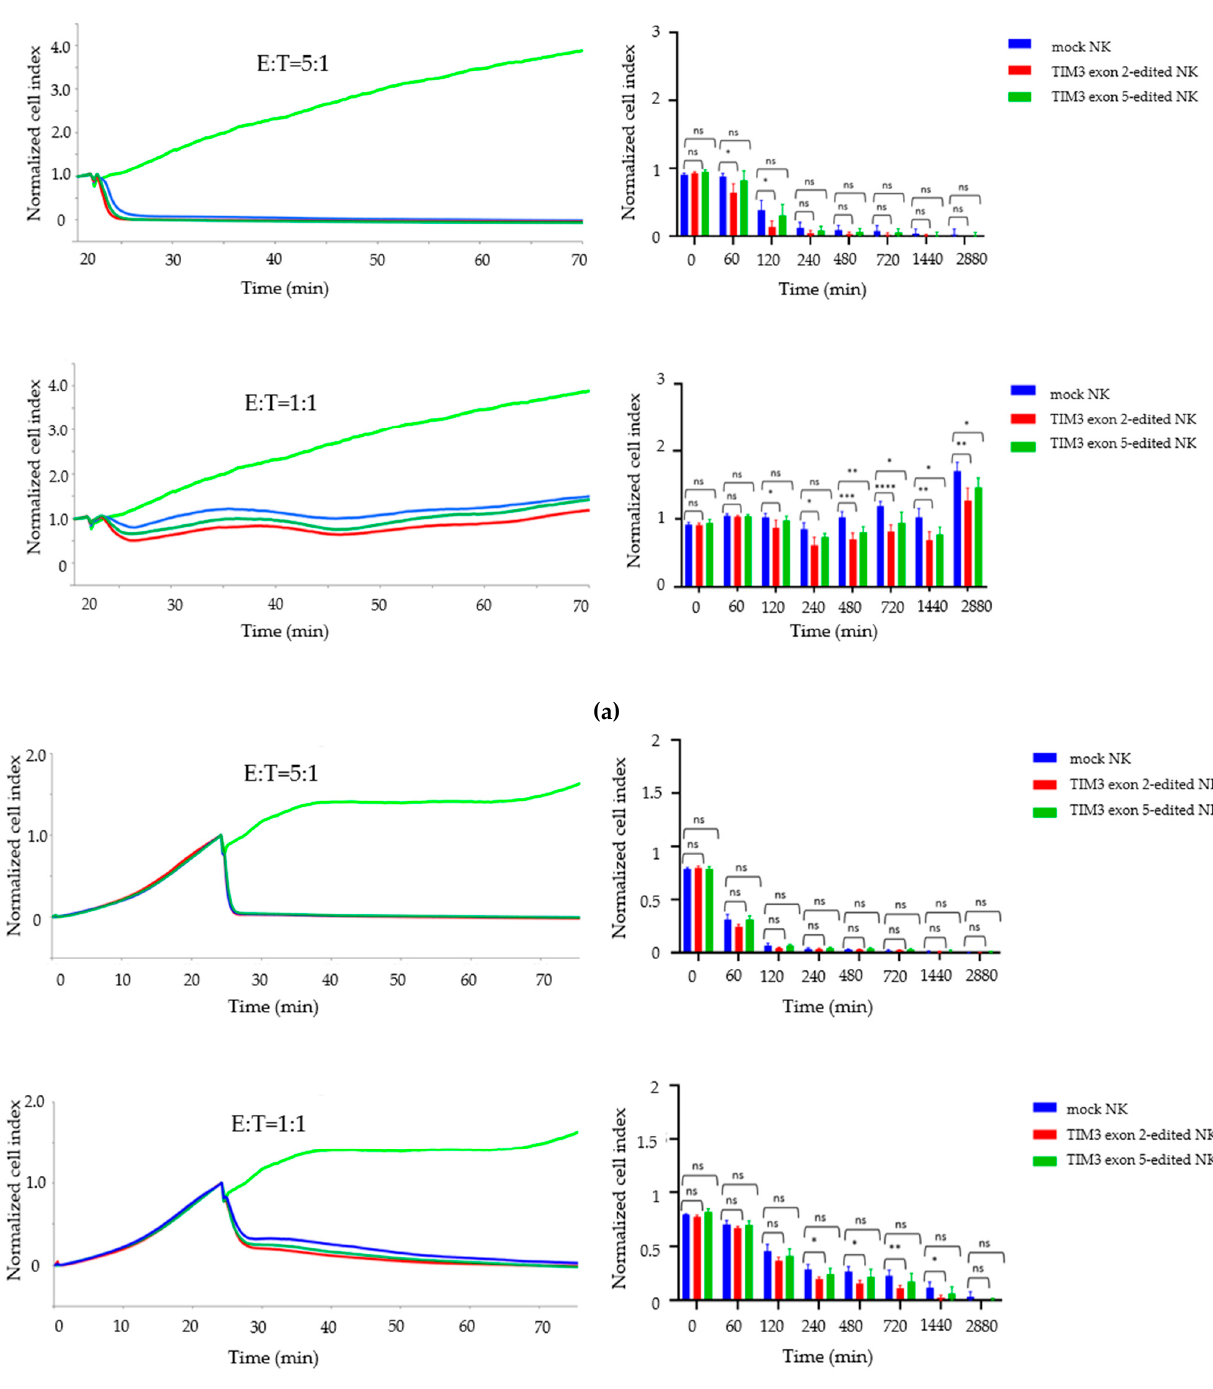
Figure 5. Enhanced growth inhibition of GBM cells by TIM3 knockout in NK cells. The graphs on the left show the representative growth curve of T98G ( a ) and LN-18 cells ( b ) co-cultured with mock NK cells (blue), TIM3 exon 2-edited NK cells (red), and TIM3 exon 5-edited NK cells (green) at effector-to target (E:T) cell ratios of 1:1 and 5:1. The growth curve (light green) indicates cell lines only. The graphs on the right show the real-time cell analysis based growth inhibition assays. The X- and Y-axes show the co-culture time and relative normalized cell index, respectively. Data shown are the mean ± SD of 5–6 experiments. Statistical differences were determined by two-way ANOVA followed by Tukey’s test. **** p < 0.0001, *** p < 0.001, ** p < 0.01, * p < 0.05, ns: not significant.